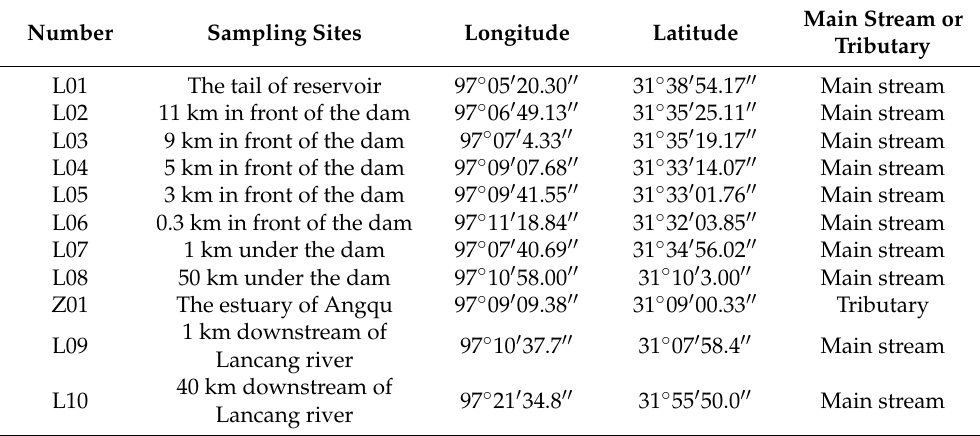
Table 1. Basic information table of sampling